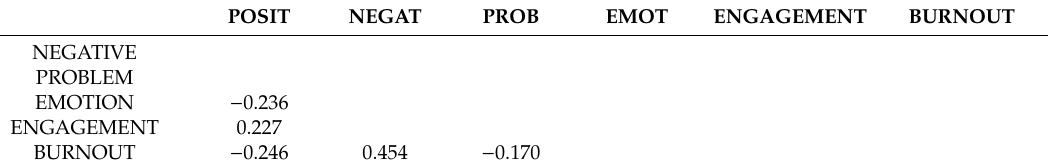
Table 11. Standardized Indirect E ff ects (Default model). Test